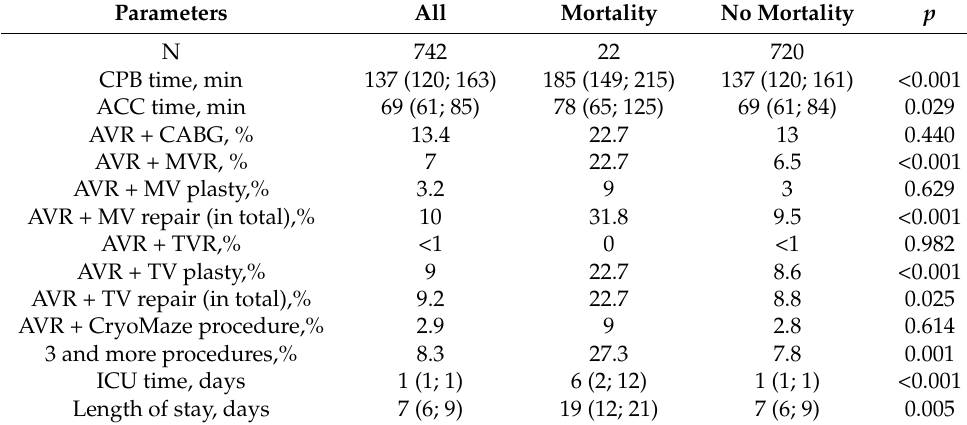
Table 3. Operational and postoperative parameters of